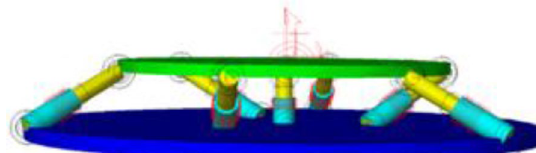
Figure 8 Simulation model of the 7-SPS passive-input overconstrained mechanism